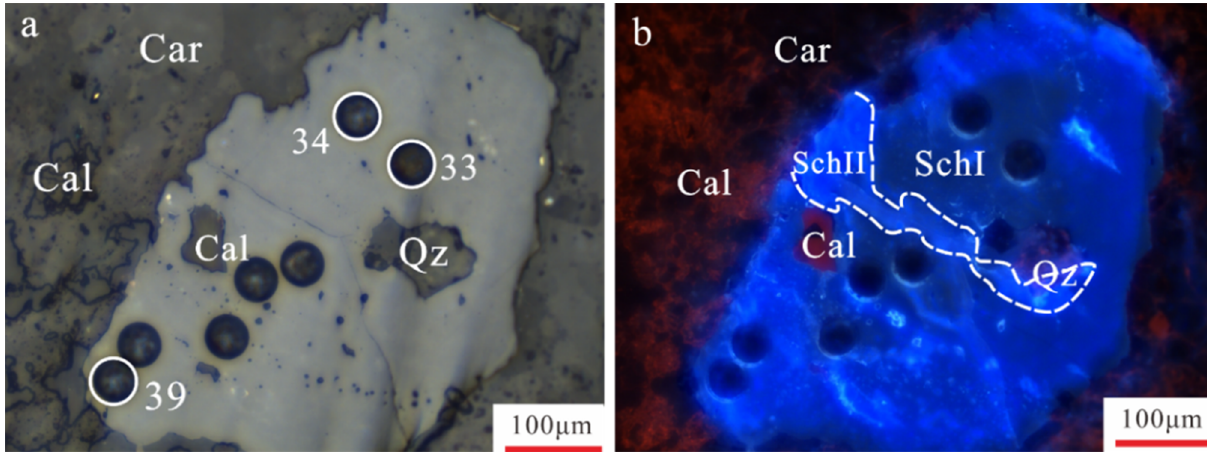
Figure 10. Characteristics of the typical “double linear grain” in SchC within endoskarn, showing the filling texture of late scheelite II into early scheelite I. ( a ) The image of the double linear grain taken under the microscope by reflected light ( b ) The OM-CL image of the double linear grain.